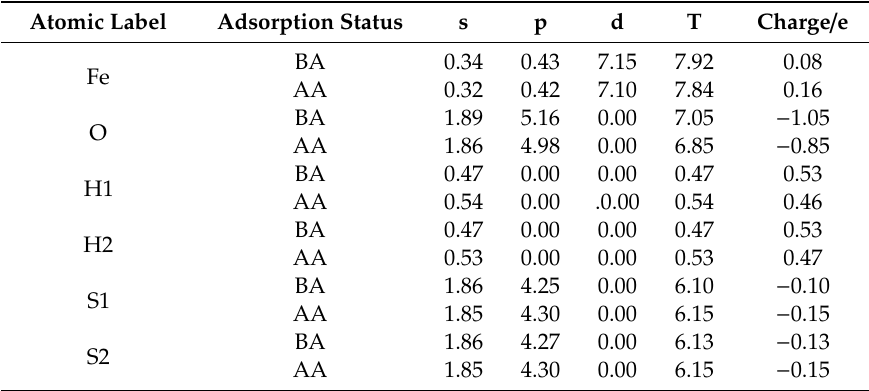
Table 6. MCP of atoms at the ortho-position.